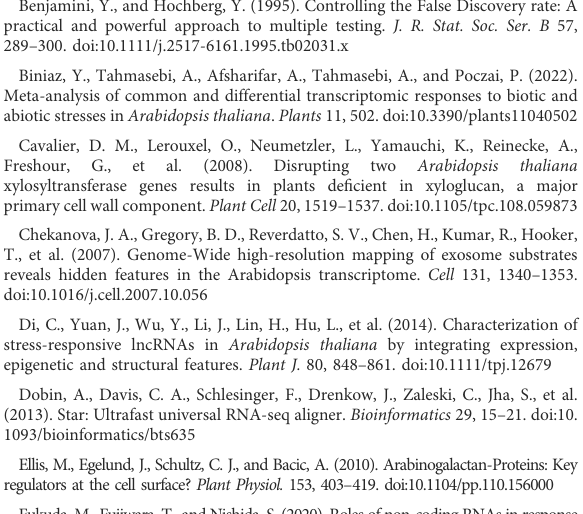
Differentially expressed genes (DEGs) identi fi ed in the four independent and paired comparisons performed: GSNO-treated rhd6 vs. untreated rhd6 , IAA-treated rhd6 vs. untreated rhd6 , GSNO-treated rhd6 vs. IAA- treated rhd6 , and WS-2 vs. untreated rhd6 (FDR < 0.05). Upregulated and downregulated genes for each condition are shown, along with log2FC and false discovery rate (FDR) values.